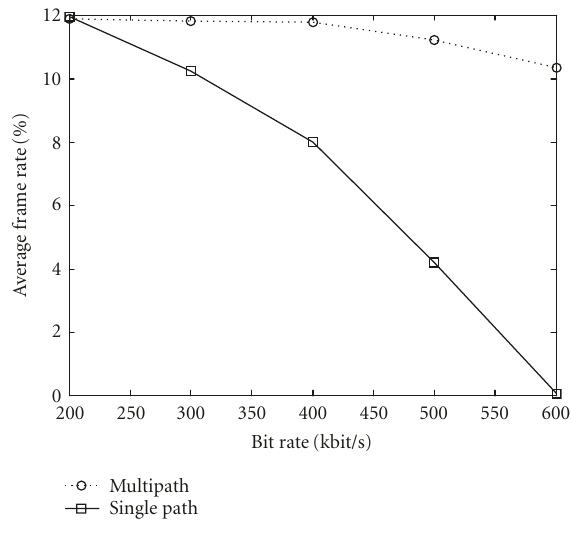
Figure 14: Video frame corruption percentage. Figure 15: Average video frame rate, fr .